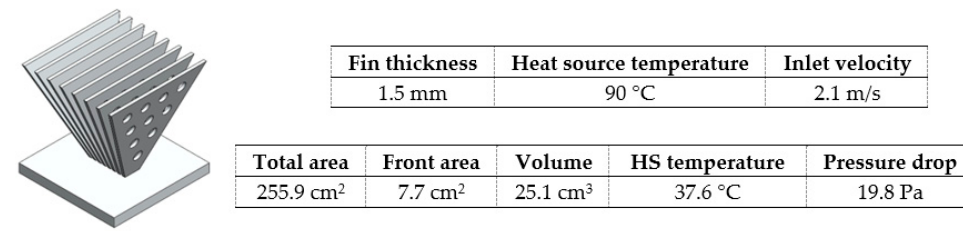
Figure 10. Model E variants.